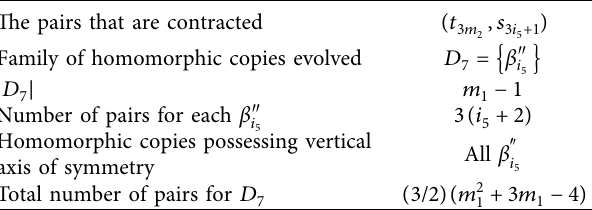
Table 6: Necessary information regarding homomorphic